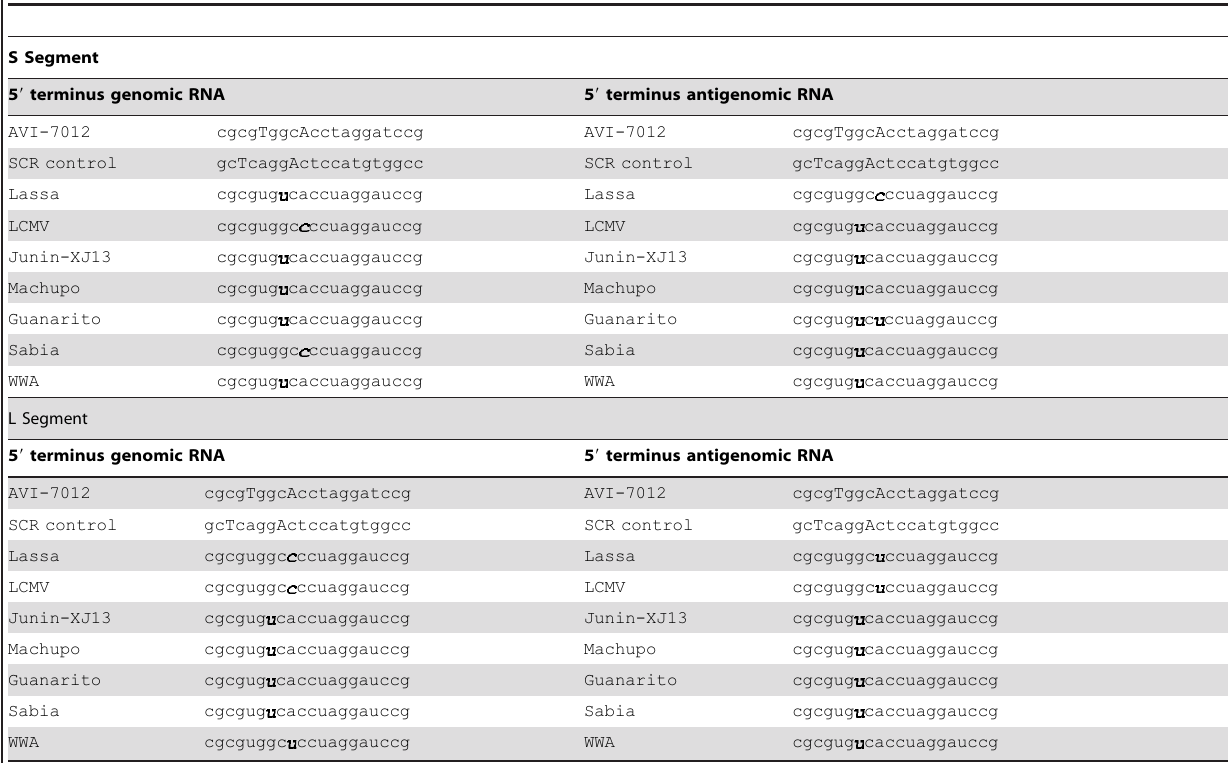
Table 1. Sequence of AVI-7012 and alignment to Arenavirus L and S genome and anti-genome